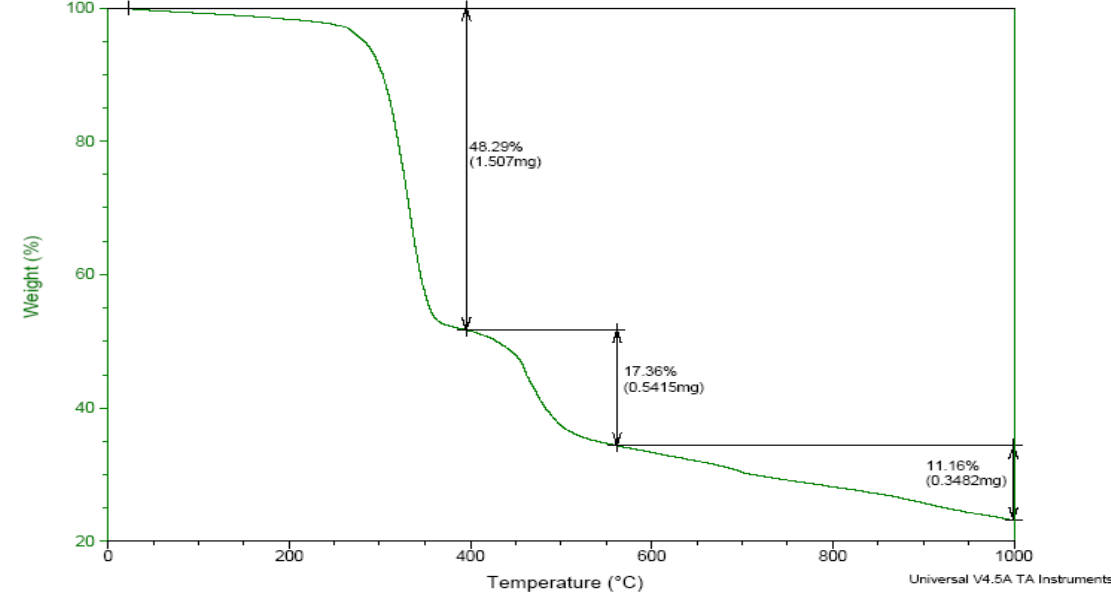
Figure 2: TGA for PVC